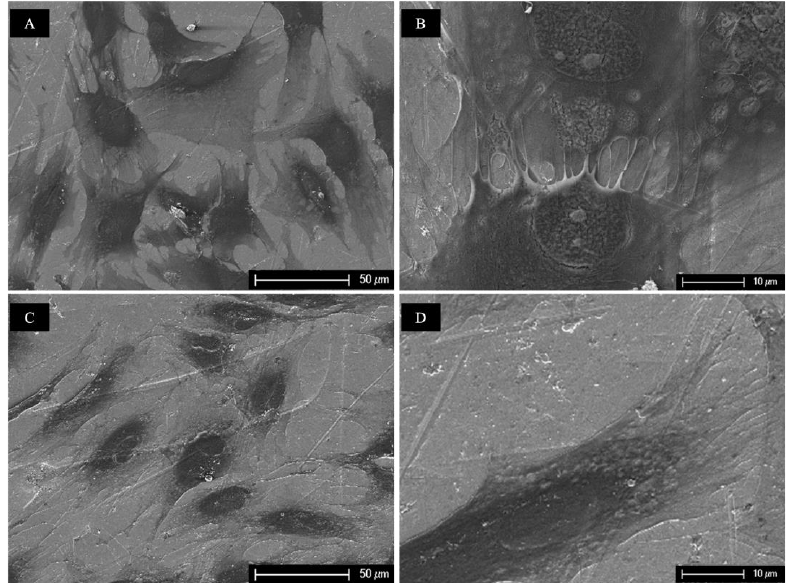
Figure 7. Representative scanning electron microscopy images of fibroblasts on machined titanium discs after 4 h of cultivation. ( A , B ) Plasma-treated samples. Fibroblasts are larger and show more intensive attachment and intercellular contacts in comparison to ( C , D ) controls without plasma treatment.